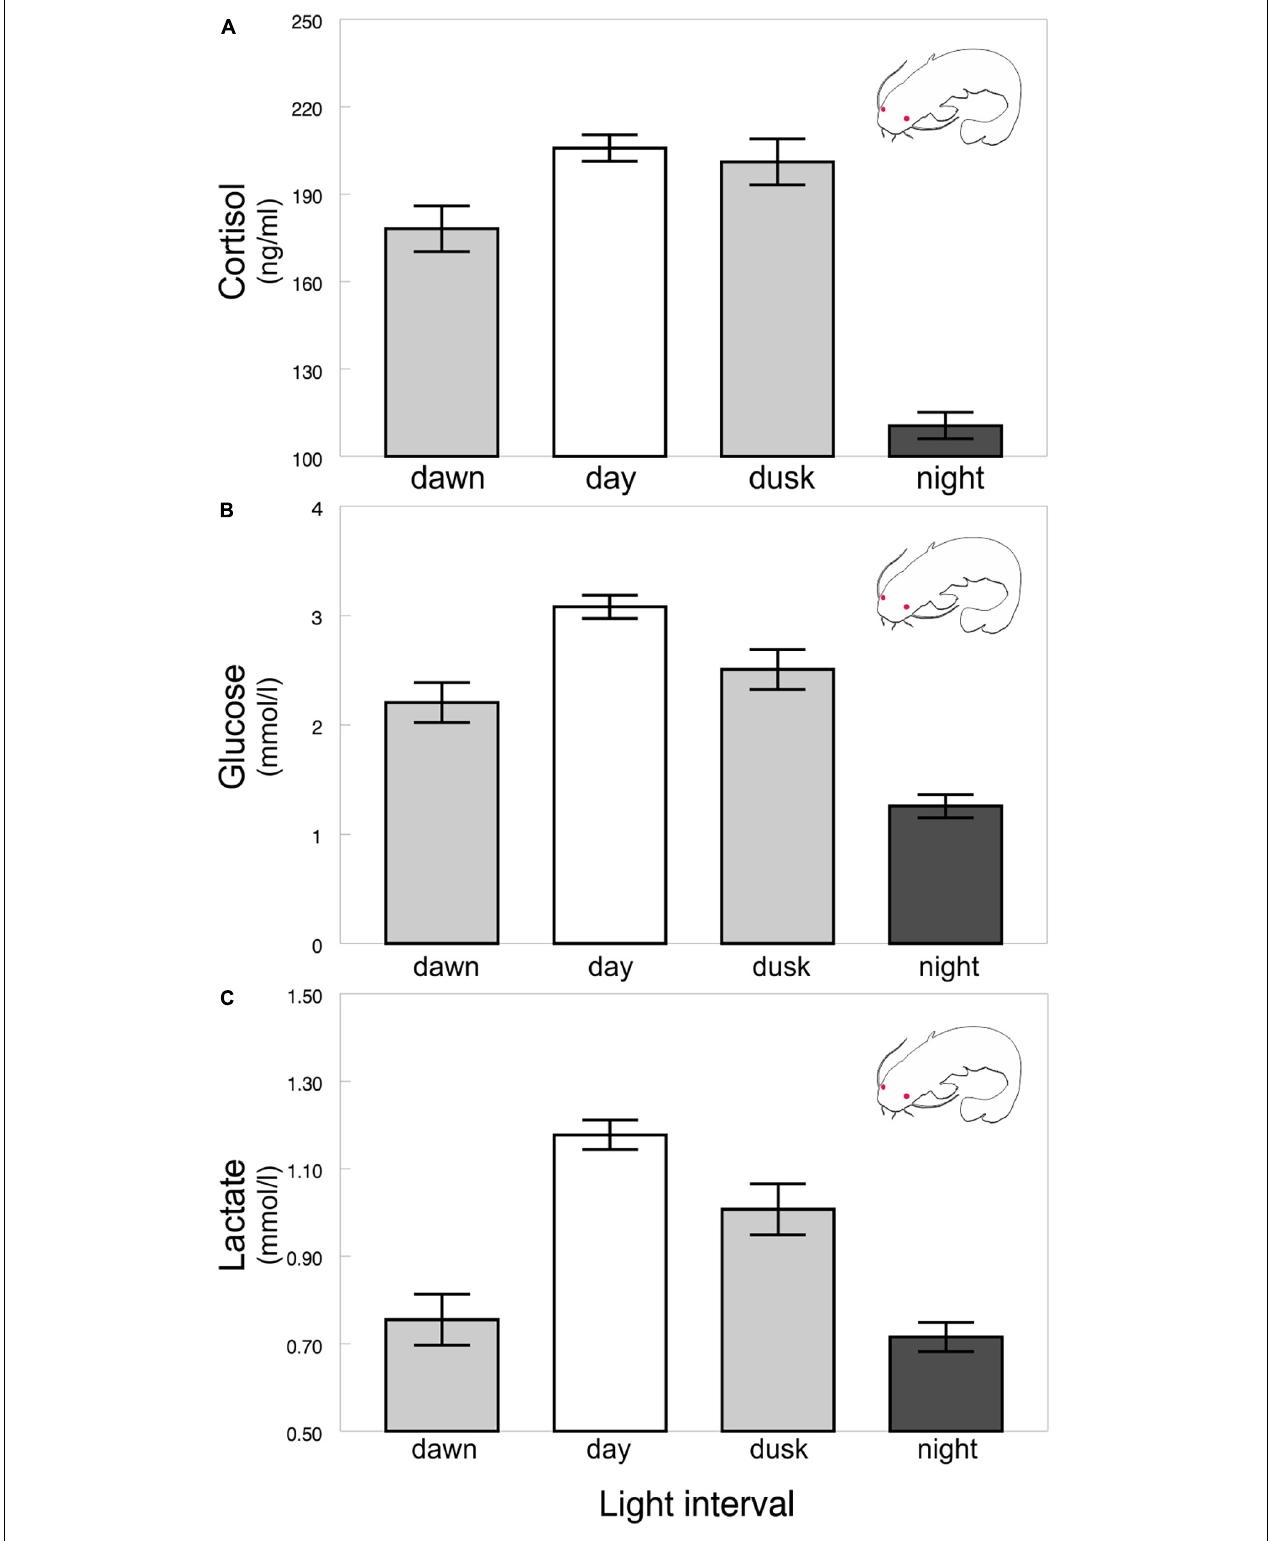
FIGURE 4 | Albino catfish blood cortisol (A) , glucose (B) , and lactate (C) levels across light intervals. Values ( ± SEs) of biochemical indices are predicted from the mixed models (i.e., presented data are after the adjustment by the statistical model).